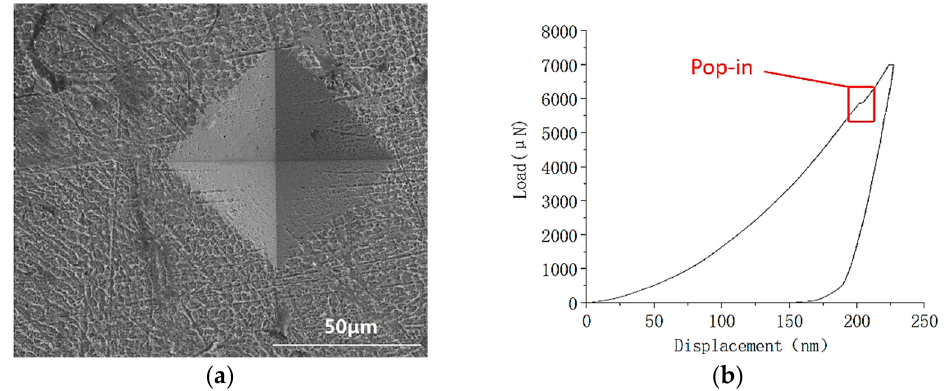
Figure 3. ( a ) Indentation created in the micro-hardness testing; ( b ) Load–Displacement curve of the sample made with 275 W laser power (LP), 5.5 mm/s scanning speed (SS), 20% powder ratio (PR), and 5 rpm powder feed rate (PF).